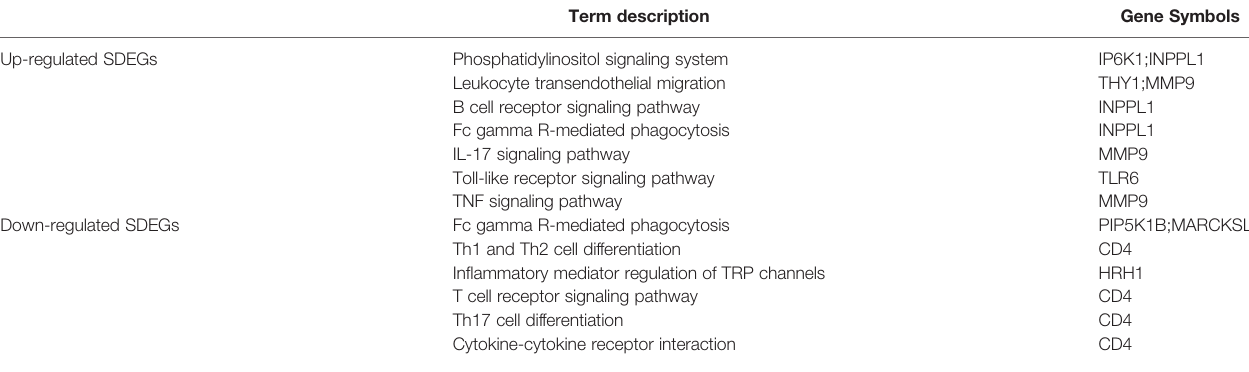
TABLE 2 | The genes in the immune-related pathways.